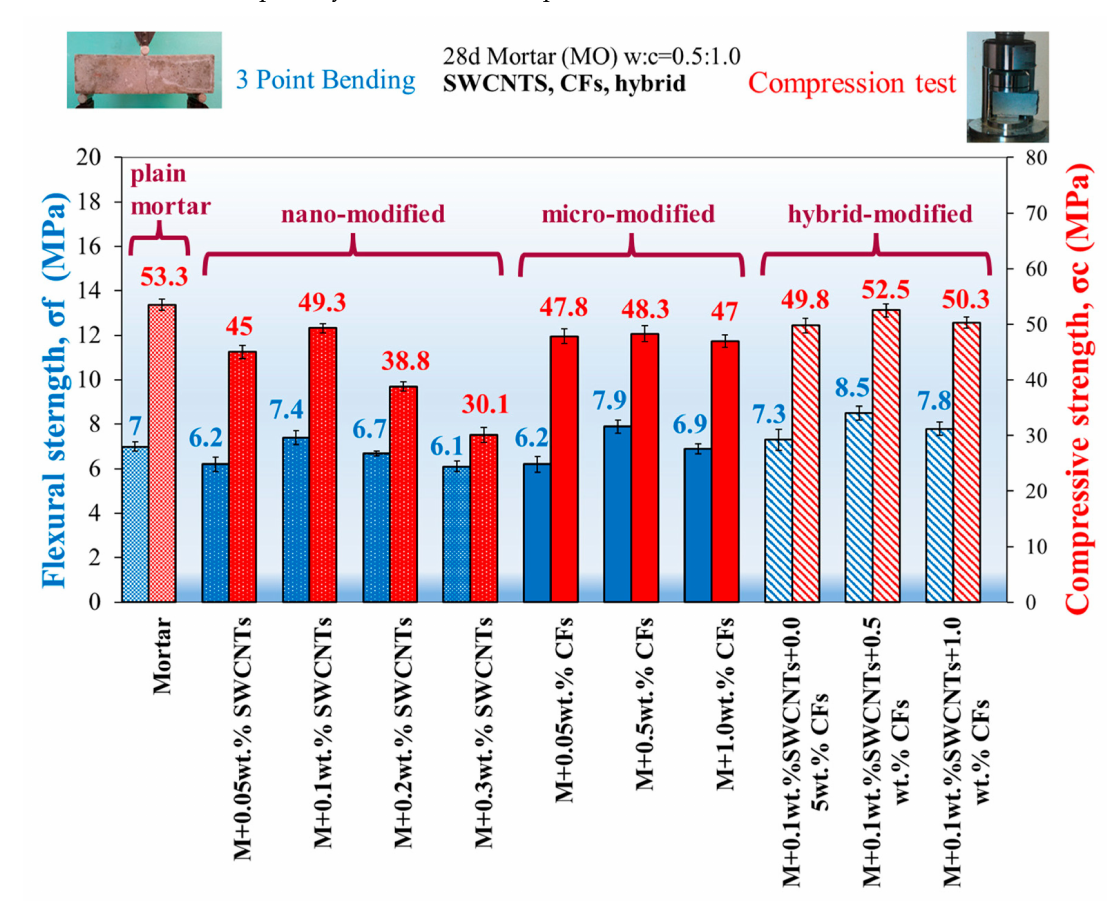
Figure 3. Average 28-day flexural strength, compressive strength, and standard deviations of plain mortar and strengthened mortars with SWCNTs, CFs, and hybrid